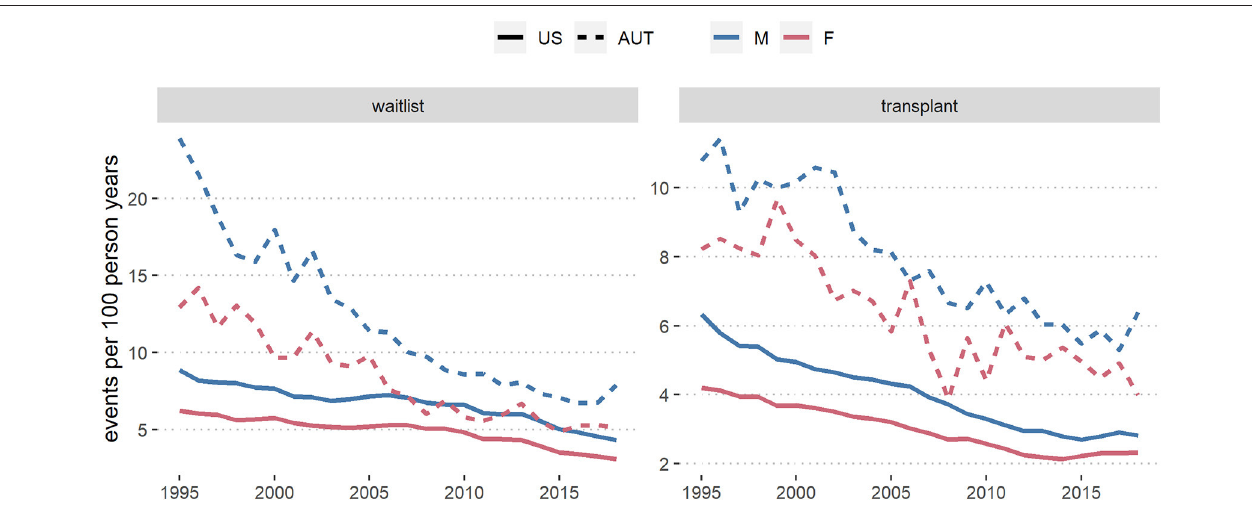
FIGURE 4 | Wait-list and transplant rates per 100 dialysis patient years in the US and in Austria (AUT) from 1995 to 2018, by sex. Results are based on data from the ADTR/Eurotransplant (AUT) (26, 29) and USRDS (US) (28). US the advantage for men disappeared only within the most recent decade (2008–2018). Wait-listing rates by sex moved closer together in Austria than in the United States, indicating